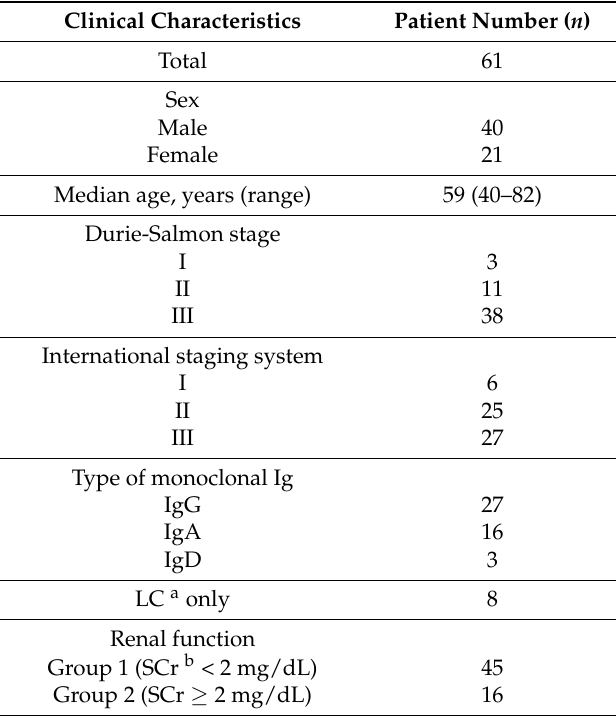
Table 1. Clinical characteristics of patients with de novo multiple myeloma (MM).